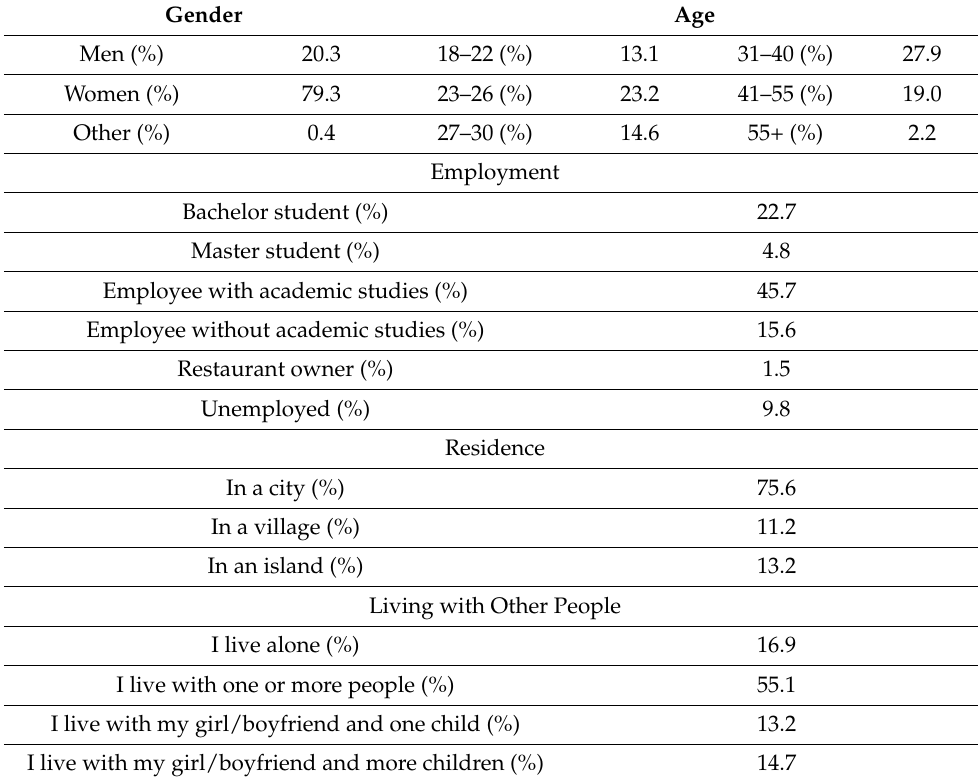
Table 2. Demographic